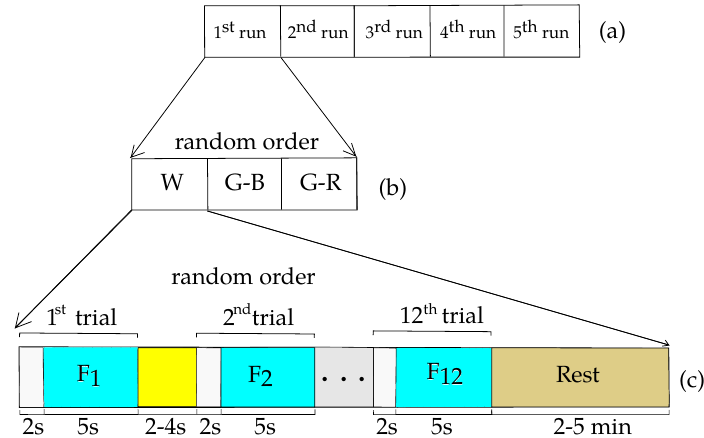
Figure 3. Protocol of the experiment: ( a ) experiment divided into five runs; ( b ) three colored stimuli presented in random order to each volunteer; ( c ) 12 frequencies randomly presented for each colored